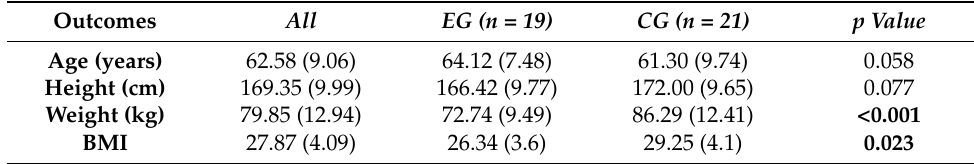
Table 2. Demographic description of the groups.